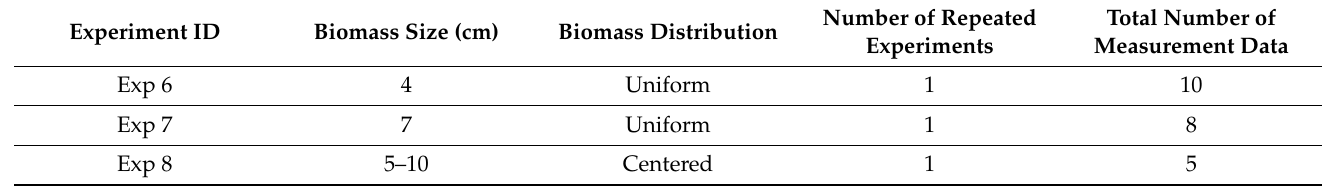
Table 2. Supplementary experiments to assess measurement sensitivity